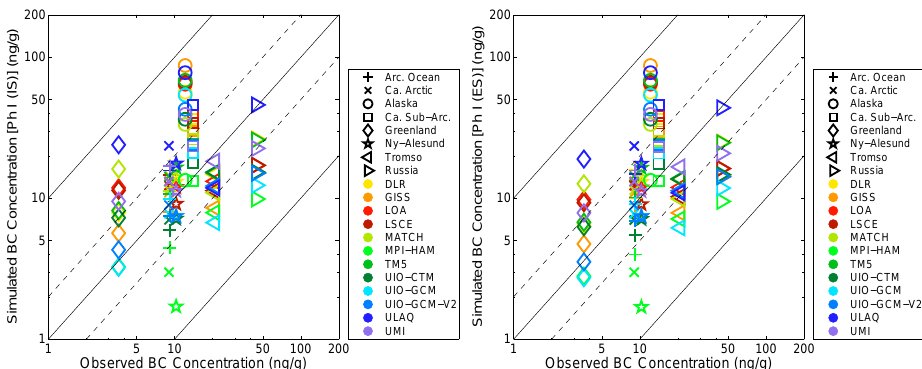
figure. The bold horizontal line shows the mean of the observations and models for each scenario. Each colored dot represents the mean of a particular model’s simulated BC-in-snow concentration averaged over grid cells matching the location, time, and depth of measurements.